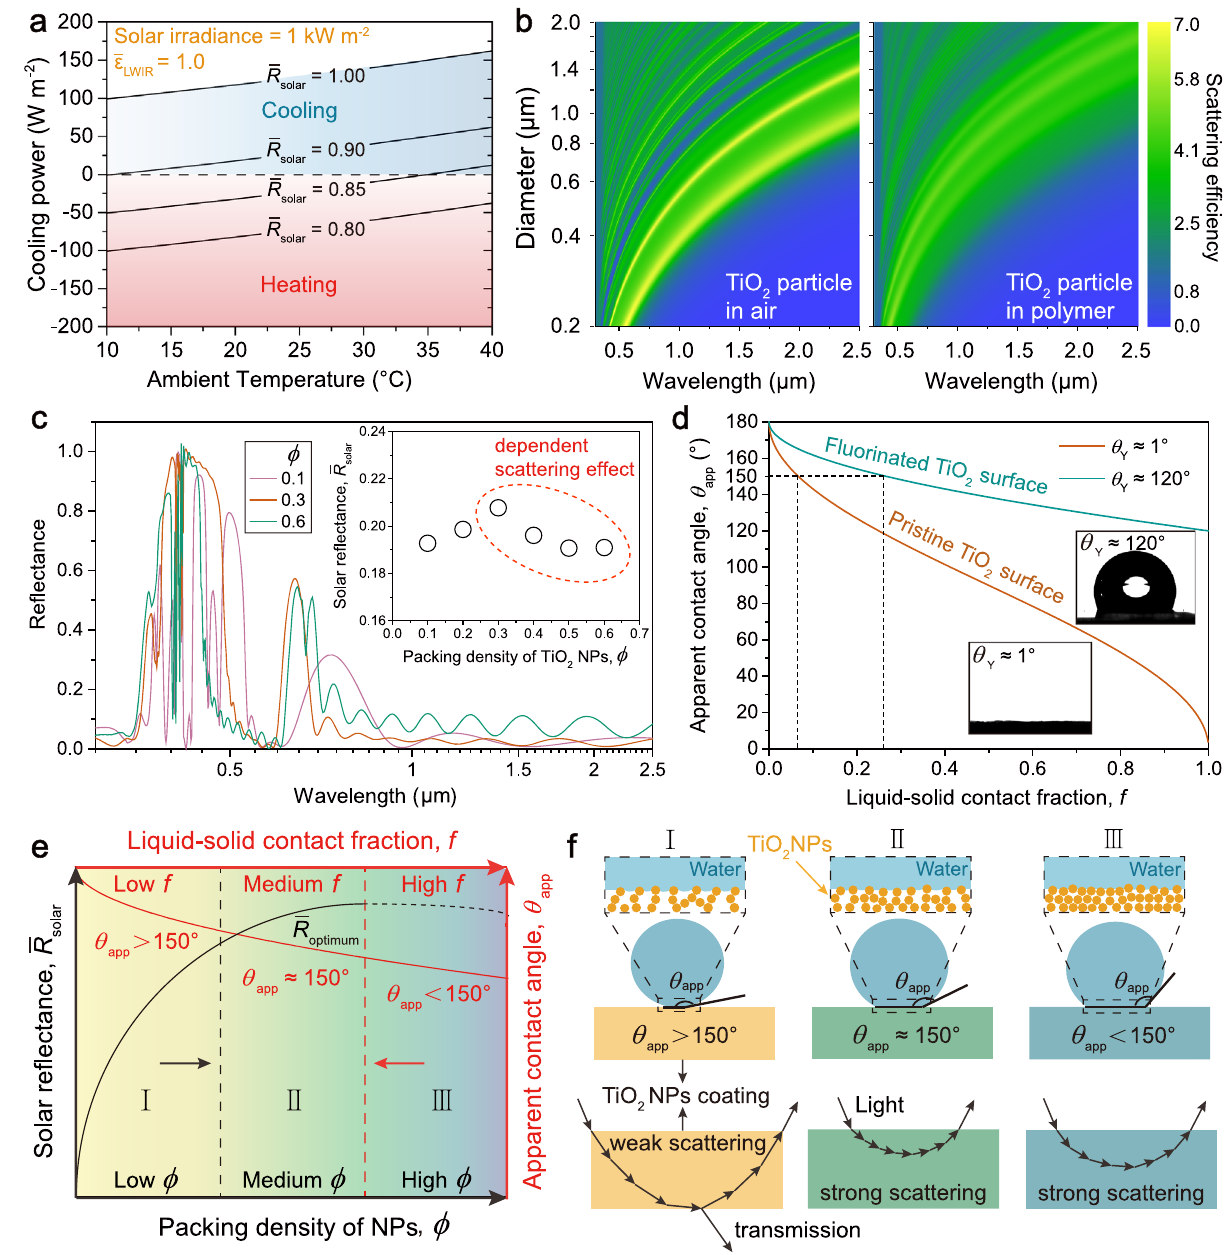
Fig.1| DesignofAACP.a Netcoolingpowerasafunctionof ambienttemperature for various R ̅ solar . Theoretical calculation is based on steady state heat transfer balance analysis (details in Method). Subambient cooling is dif fi cult to